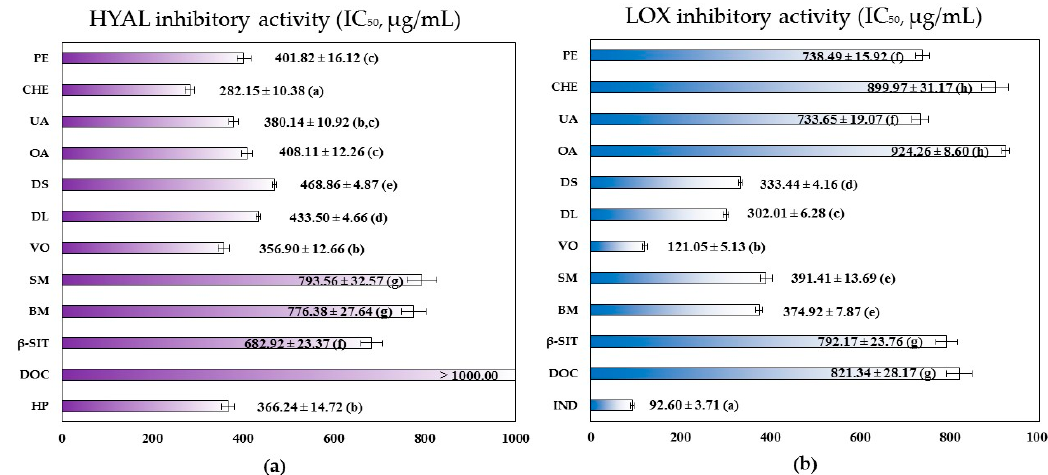
Figure 2. Anti-inflammatory activity of G. procumbens dry lipophilic leaf extracts; inhibitory activity on: ( a ) hyaluronidase and ( b ) lipoxygenase. Results are presented as mean values ± SD ( n = 3 × 2) represented by error bars; IC 50 , 50% inhibition of enzyme activity; for each parameter different lowercase letters given in parentheses (a–h) indicate significant differences between the mean values ( p < 0.05) in the Tukey’s test; abbreviations: PE , petroleum ether extract; CHE ; chloroform